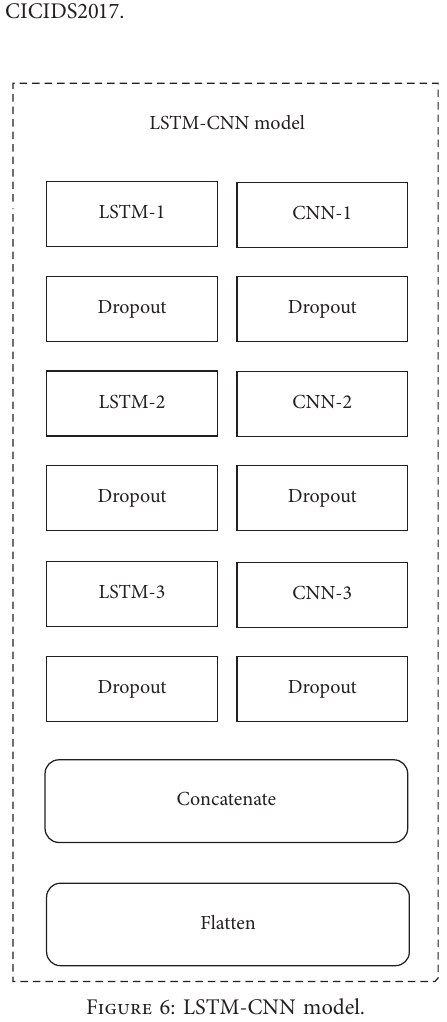
Figure 6: LSTM-CNN